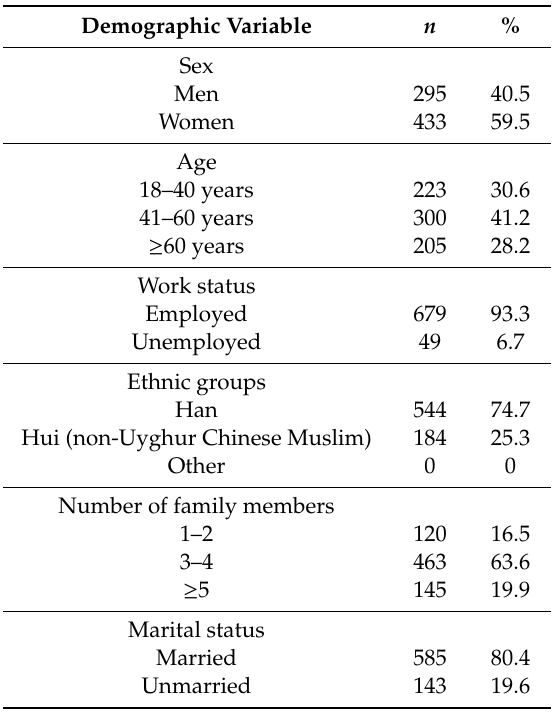
Table 1. Demographics of the participants ( n = 728).